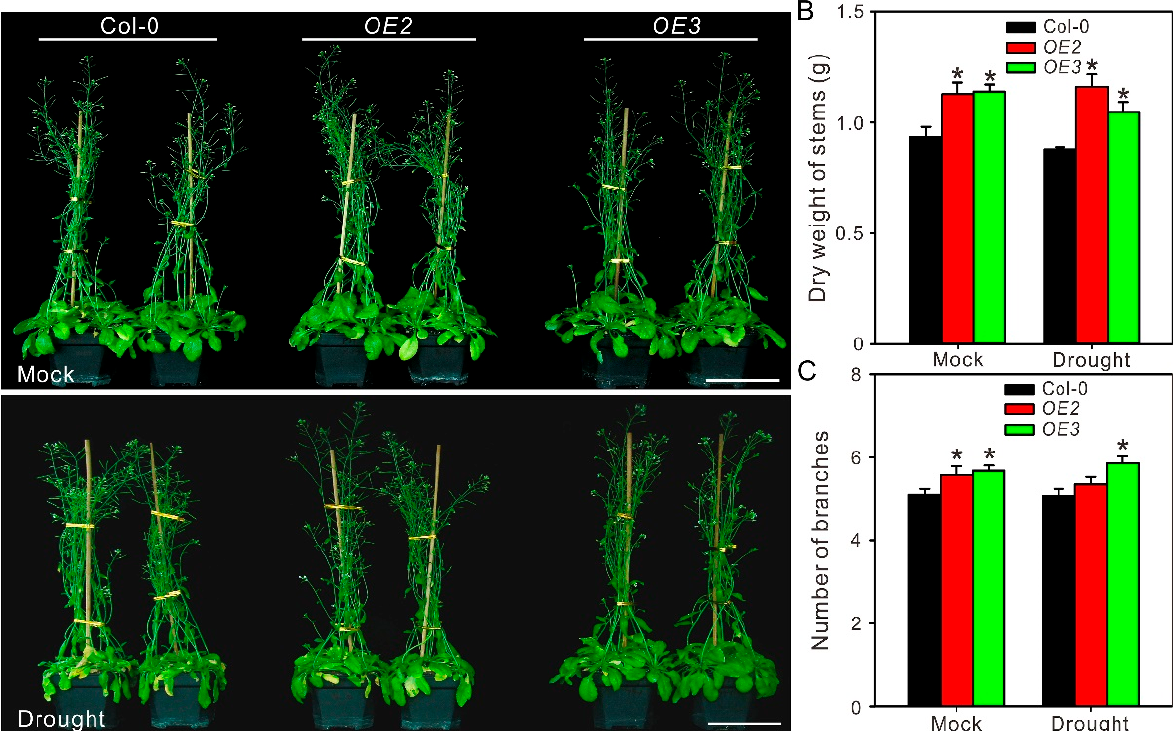
Figure 5. Overexpression of ZxPIP1;3 improves growth vigor under drought treatment. ( A ) Phenotypes of soil-cultured seedlings treated with (Drought) or without (Mock) period dehydration. Bar = 10 cm. ( B , C ), Dry weight of stems ( B ) and number of branches ( C ) of plants treated as described in the legend of ( A ). For ( B , C ), asterisks indicate significant differences from Col-0 ( n = 13 per column. * p < 0.05, one way ANOVA).